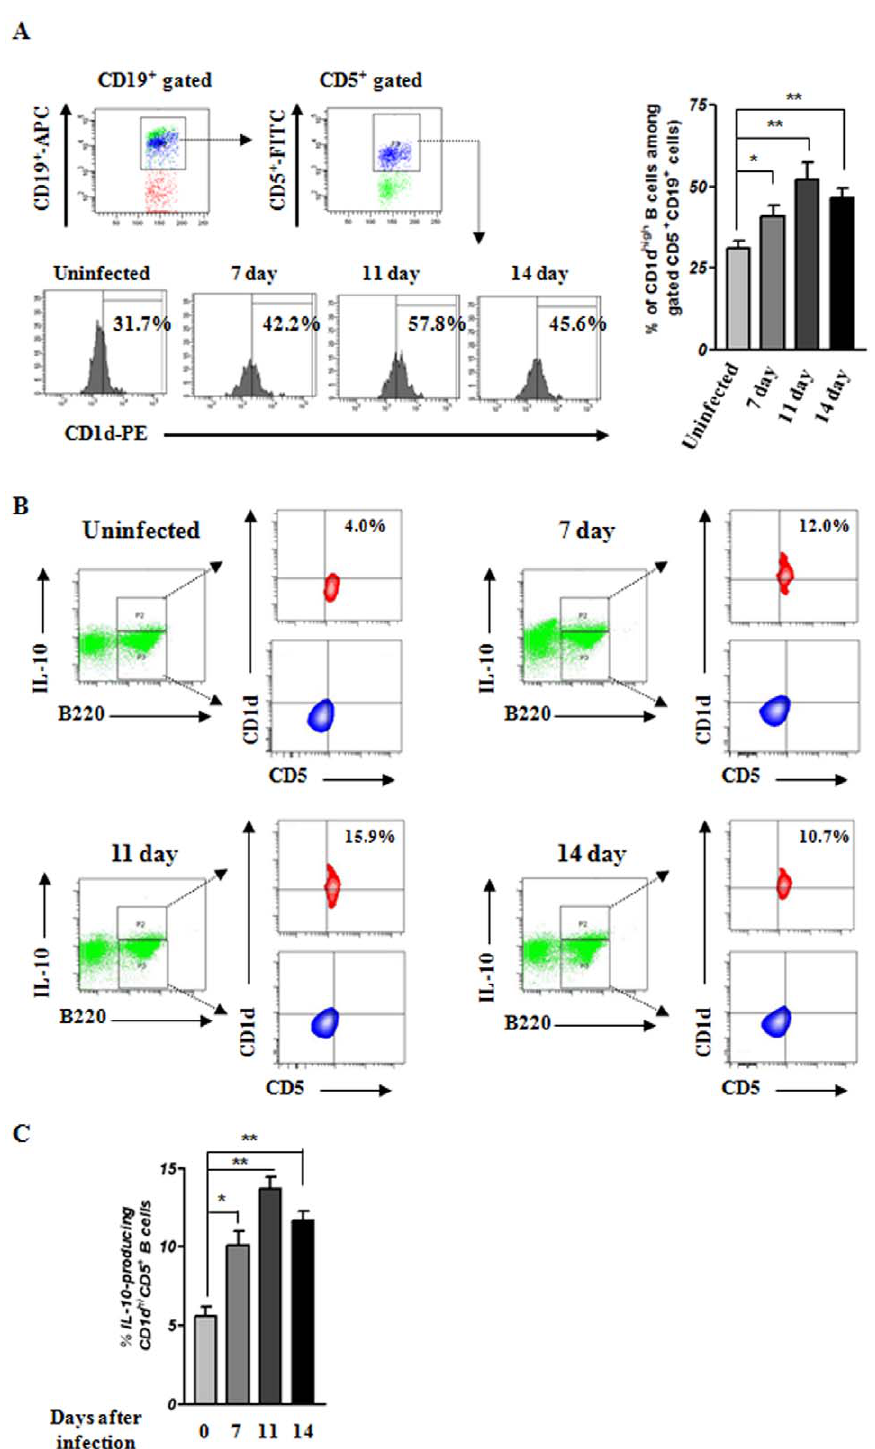
Figure 5. Identification of splenic IL-10-producing CD1d high CD5 + Breg population induced by B.microti infection. Splenocytes were isolated from uninfected mice and at days 7, 11, and 14 after B. microti infection. (A) Representative flow cytometric data shows the frequency of CD1d high B cells among gated CD5 + CD19 + B cells. Bar graph indicate the mean mean percentages 6 the standard deviation of CD1d high CD5 + CD19 + B cells in one representative experimental group consisting of five mice. (B) To examine the capacity of B. microti infection to induce IL-10-producing CD1d high CD5 + Bregs, splenocytes isolated from infected or uninfected mice were stained with antibodies against CD19, B220, CD1d, CD5, and IL-10. The gating strategy used to identify IL-10-producing CD1d high CD5 + B cell is also depicted. (C) Bar graphs indicate the mean percentages 6 the standard deviation of splenic CD1d high CD5 + B220 + CD19 + B cells that produced IL-10 in one representative experimental group consisting of five mice. * P , 0.01 and ** P , 0.001 compared with the group of uninfected mice. Results presented were obtained by analyzing cells from individual mice and represent five independent experiments.